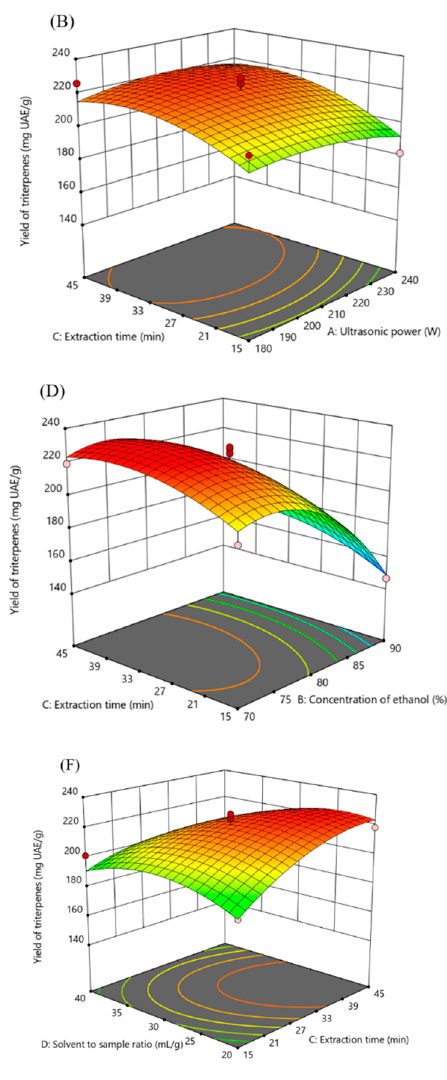
Figure 2. The response surface plots of the four factors interaction on the triterpenes yield ( A ) concentration of ethanol and ultrasonic power; ( B ) ultrasonic power and extraction time; ( C ) ultrasonic power and solvent to sample ratio; ( D ) extraction time and concentration of ethanol; ( E ) concentration of ethanol and solvent to sample ratio; and ( F ) extraction time and solvent to sample ratio.